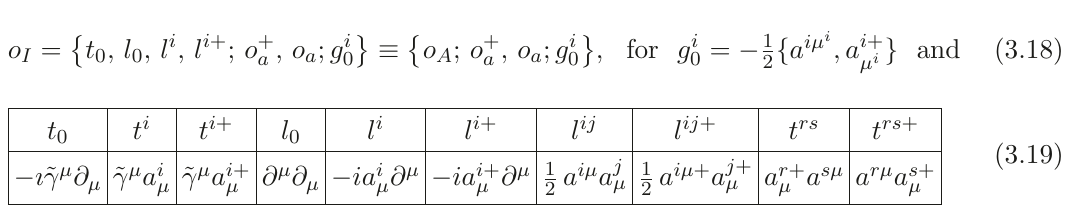
for the indices i 1 , i 2 of table 1 in the quantity C { i 1 D i 2 } i 3 θ i 3 i 2 } imply